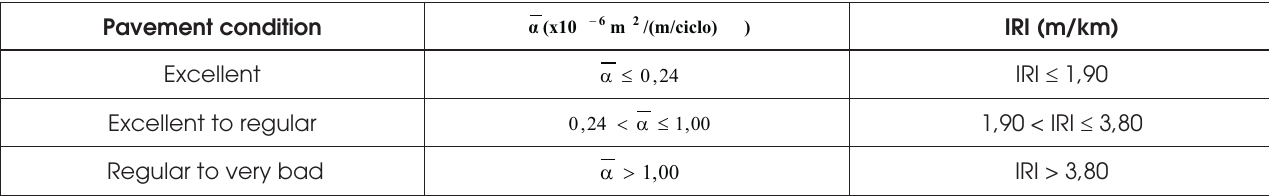
Correlation between the classifications adopted in Brazil (IRI) and by ISO Pavement condition )/(m/ciclo)m(x10α 26 - IRI (m/km) Excellent IRI ≤